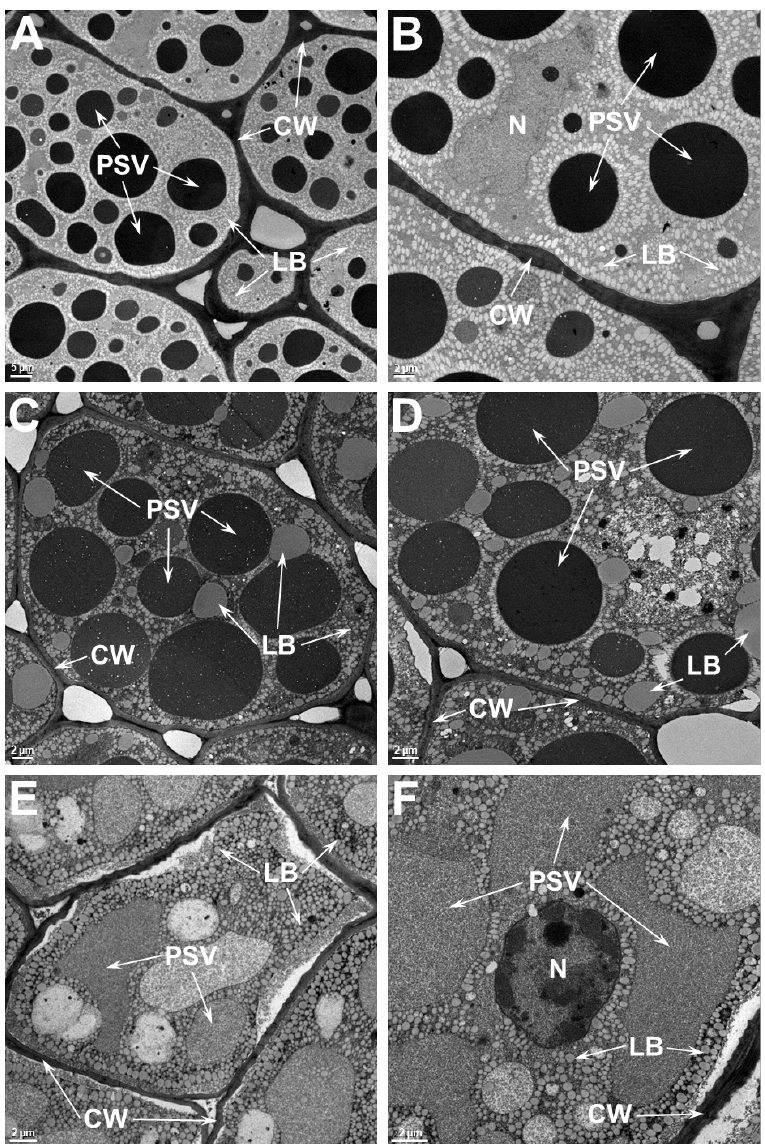
Figure 5. Transmission electron micrographs of tolerant (TG) soybean cotyledon grown at different temperatures. Low and high magnification micrographs of soybean cotyledons that were grown at 28/22 °C ( A and B ) or 36/24 °C ( C and D ) and 42/26 °C ( E and F ) day/night temperatures. Numerous protein storage vacuoles and lipid bodies are observed in these cells. Note the distorted appearance and size of protein storage vacuoles in the cotyledonary cells of tolerant soybean genotype grown at 42/26 °C. PSV, protein storage vacuoles; LB, lipid bodies; CW, cell wall; N, nucleus. A side by side ultrastructural comparison between SG and TG seeds indicated no obvious differences between the two when grown at 28/22 °C. However, at higher temperatures, clear